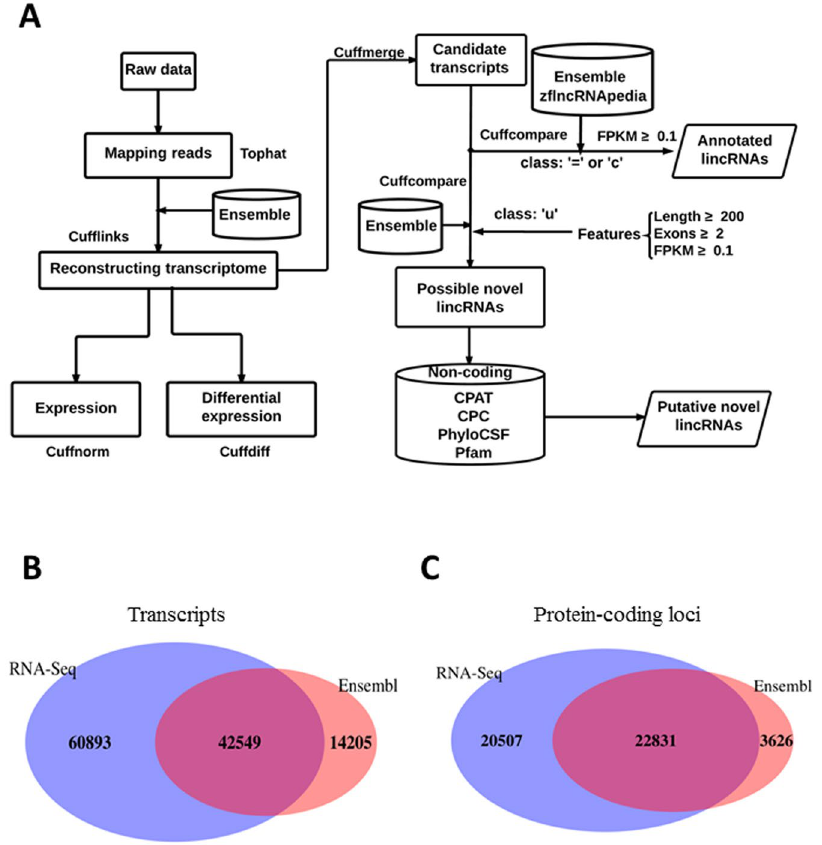
Figure 1. Overview of the RNA-seq–based cardiac transcriptome assembly. ( A ) The computational bioinformatics workflow to assemble the cardiac transcriptome and identify lincRNAs. ‘u’, intergenic transcript in Cufflinks; ‘ = ’, complete match of intron chain in Cufflinks (see Methods). ( B ) Overlap between transcripts from the RNA-seq–based cardiac transcriptome assembly (blue) and Ensembl annotated transcripts (red). ( C ) Overlap between RNA-seq–based transcripts in protein-coding loci (blue) and Ensembl annotated protein- coding transcripts